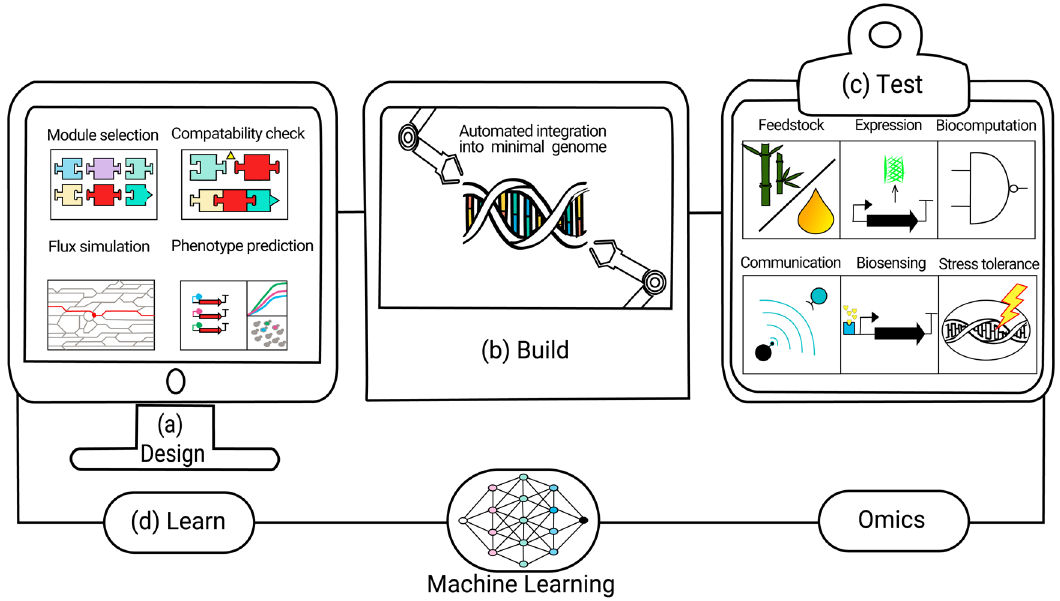
Fig. 5 | Future smart design, construction, and applications of minimal gen- omes. Syntheticminimalgenomeswillfacilitatetherealisationofsomeofsynthetic biology ’ s founding principles of modularity, computational design, automated building, and data-driven feedback into rational design iterations. a In the design stage,modules areselected fromadatabasecontainingavarietyof functionalities, such as carbon source utilisation, biosynthetic pathways, biosensing and growth- regulating modules. Modelling can then be used to ensure compatibility between modules, simulate metabolic fl ux, fi ne tune expression levels, and predict pheno- types or the yields of products. b Assistedby robotic high-throughput cloning and